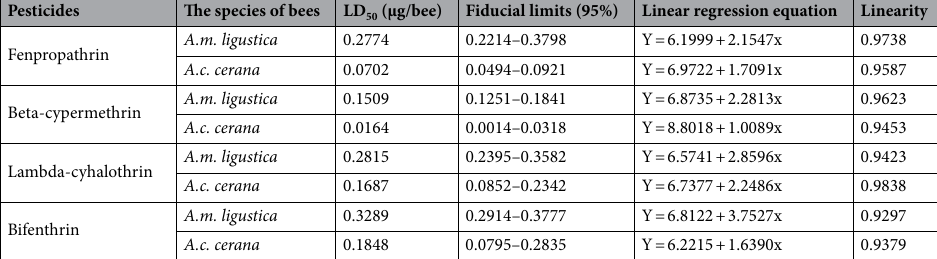
Table 2. Acute oral toxicity of four pyrethroids to A.m. ligustica and A.c. cerana at 48 h.